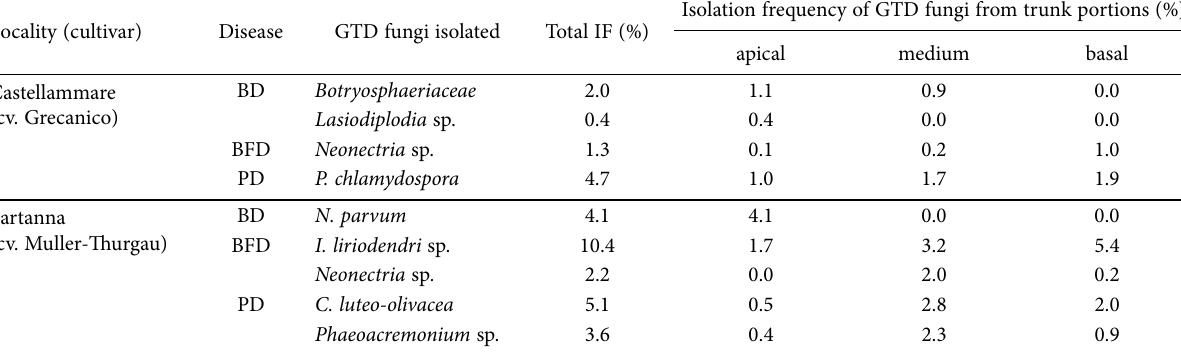
Table 3. Isolation frequency (IF) of grapevine trunk disease (GTD) fungi from symptomatic cv. Grecanico and Muller-Thurgau grapevine samples from two localities in